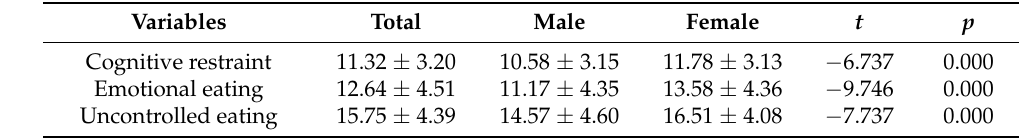
Table 2. Variables of The Three-Factor Eating Questionnaire by sex (x ± SD).